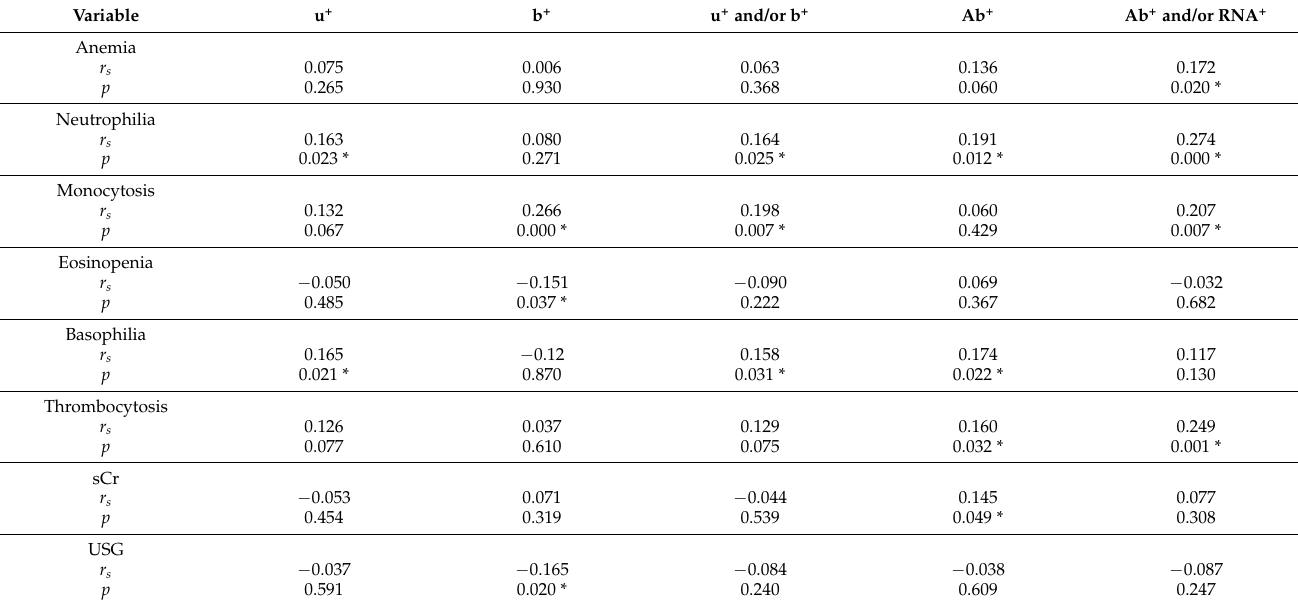
Table 5. Description of significant (*) Spearman’s rank correlation coefficient ( r s ) and p values of cat complete blood count (CBC) and renal profile abnormalities according to their FeMV positivity by qPCR FeMV from urine (u + ), blood (b + ), urine and/or blood (u + and/or b + ), FeMV antibodies (Ab + ), FeMV antibodies and/or qPCR FeMV (Ab + and/or RNA + ). sCr = serum creatinine; USG = urine specific